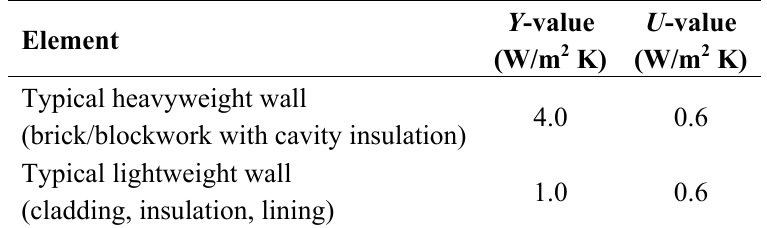
Table 1. Contrasting values of admittance and transmittance